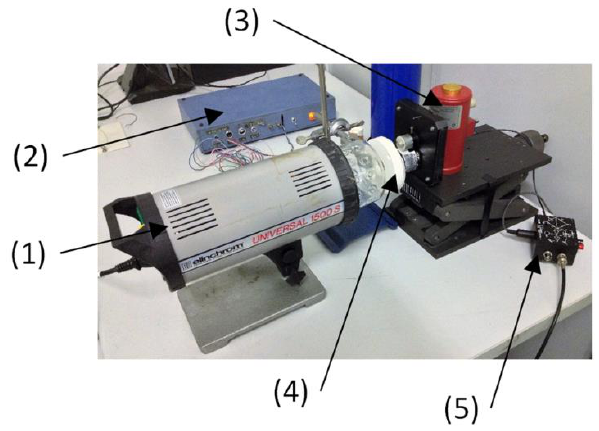
Figure 8. Photograph of the experimental apparatus of the flash method used in [30]: (1) photo-